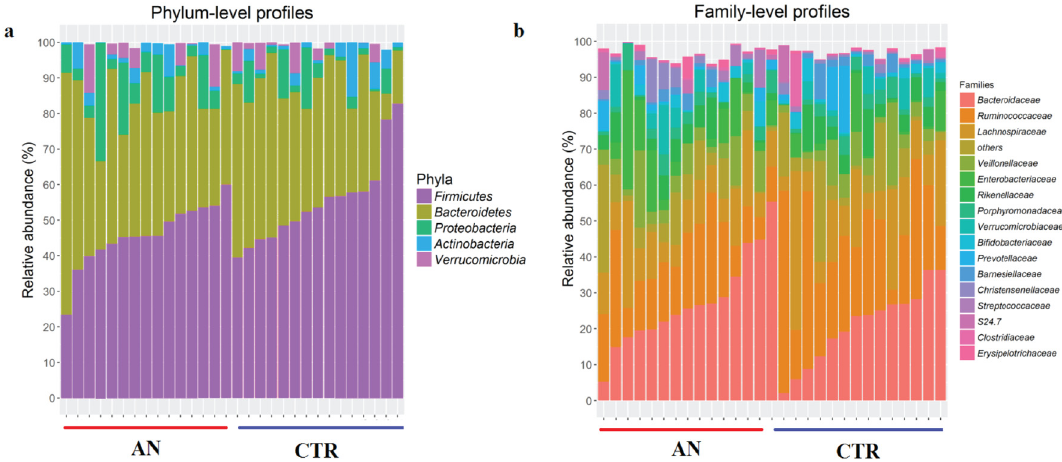
Fig 1. Relative abundance of common microbial taxa. Bar charts showingthe relative abundance of the most represented microbialtaxa, definedas having a mean relative abundance of > 1%, in stool samplesof anorexianervosa(AN, n = 15) and control (CTR, n = 15) groups. Phylum-level ( a ) and family-level( b ) taxon profiles are shown.